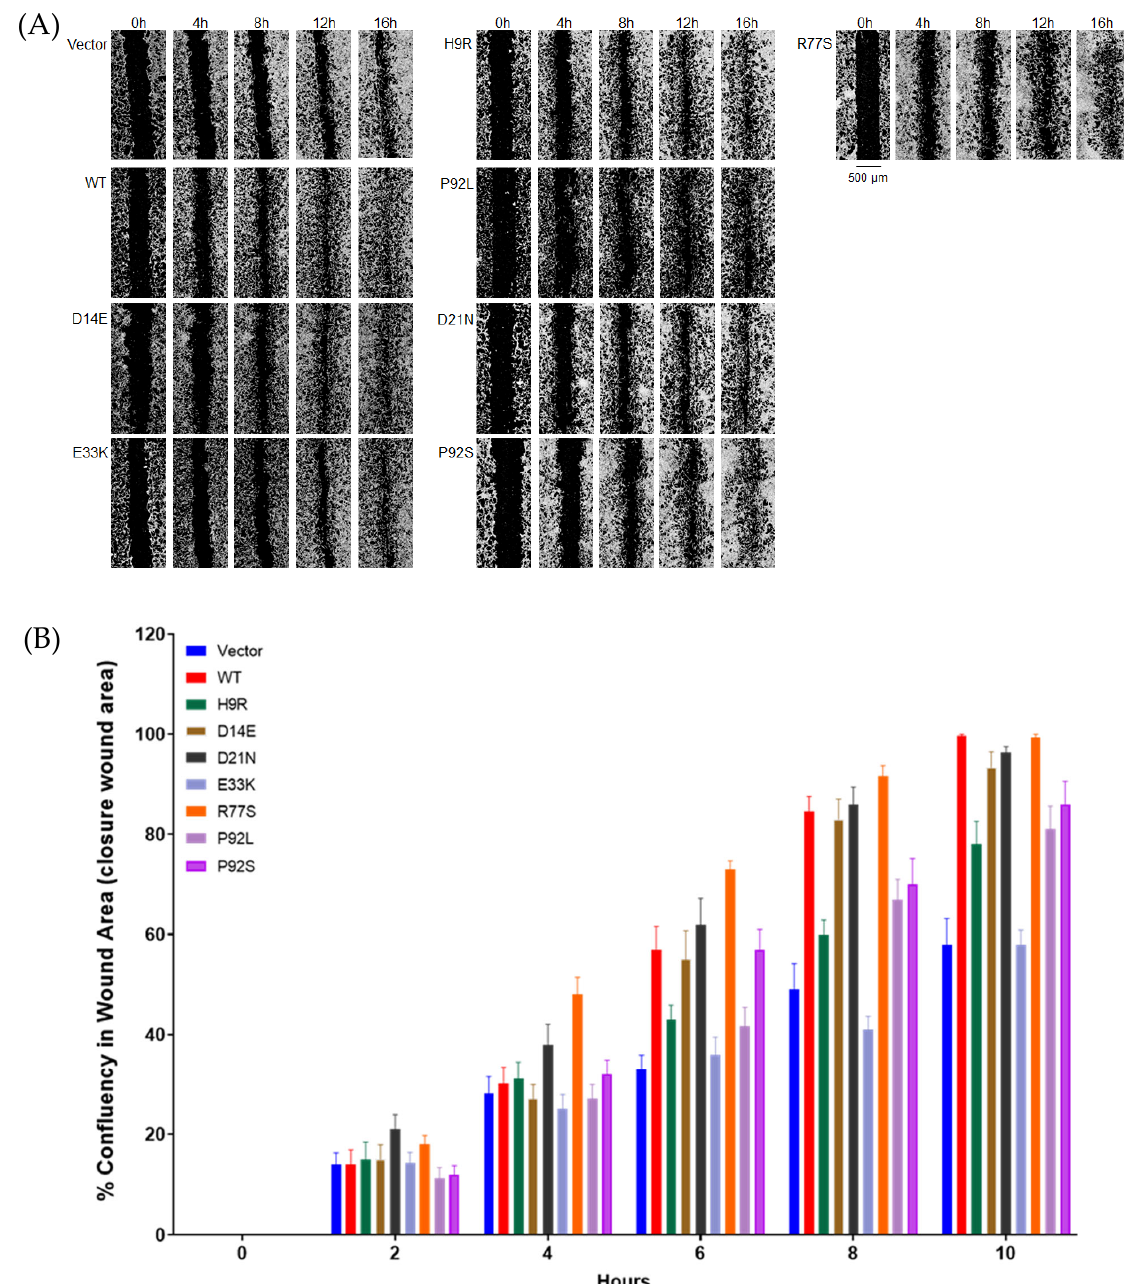
Figure 4. Migration of stably transfected NIH3T3 cell lines in a wound healing (scratch) assay. Stable NIH3T3 cell clones were plated onto 24 ‐ well plates. Wounds in the monolayer were created with an automated tool, plates were washed to remove detached cells, and closure of the wound was followed for 24 h with hourly imaging in a BioTek Lionheart FX Automated Live Cell Imager. Images are shown in Panel A and quantitation over time in Panel B. Results are expressed relative to WT E7 migration at 10 h. At 10 h: WT vs. Vector ( p = 0.0022); WT ‐ H9 R ( p = 0.0079); WT ‐ E33K ( p = 0.0022); WT ‐ D14E ( p > 0.05); WT ‐ P92L ( p = 0.0080) WT ‐ P92S ( p = 0.0082). If we apply a highly conservative Bonferroni multiple testing correction of six tests of mutant versus WT, only vector and E33K remain significant.